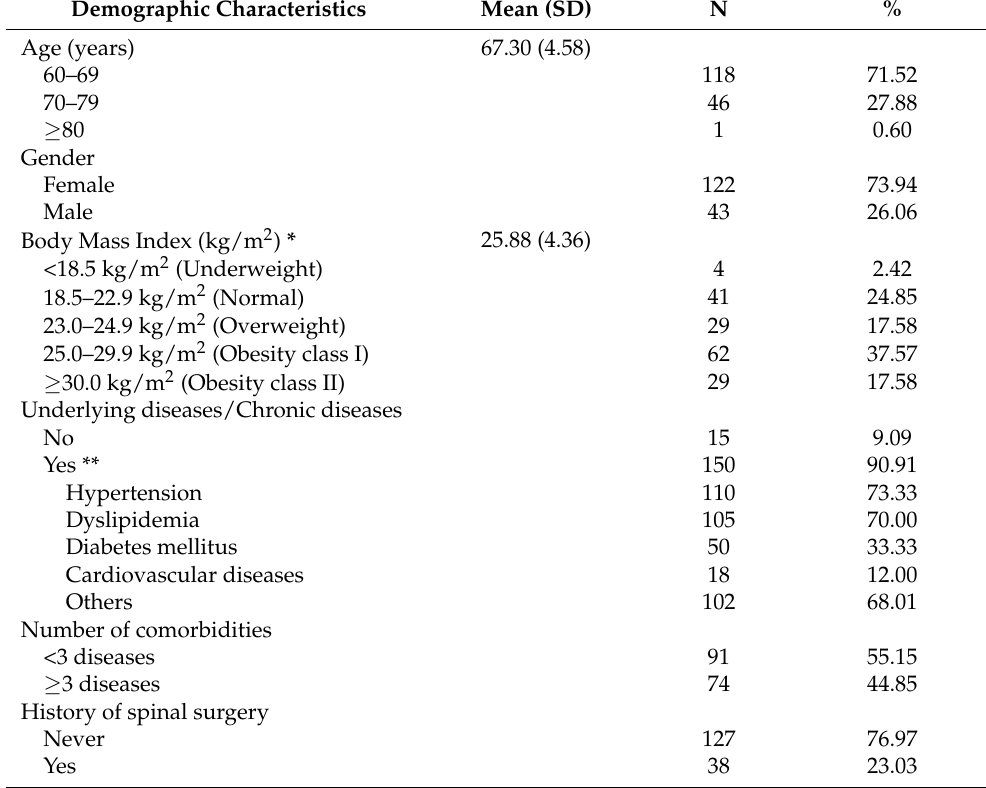
Table 1. Demographic characteristics and health information (N =